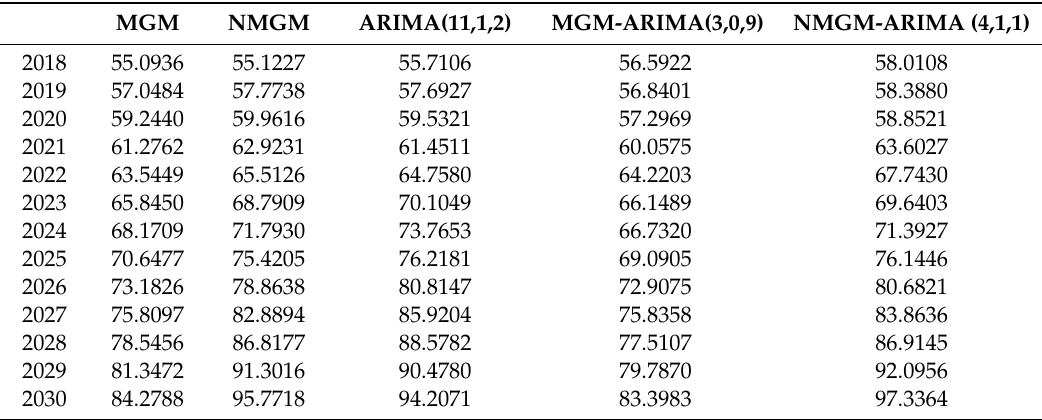
Table 16. Primary energy forecast results for East Africa ( Unit ： mtoe).